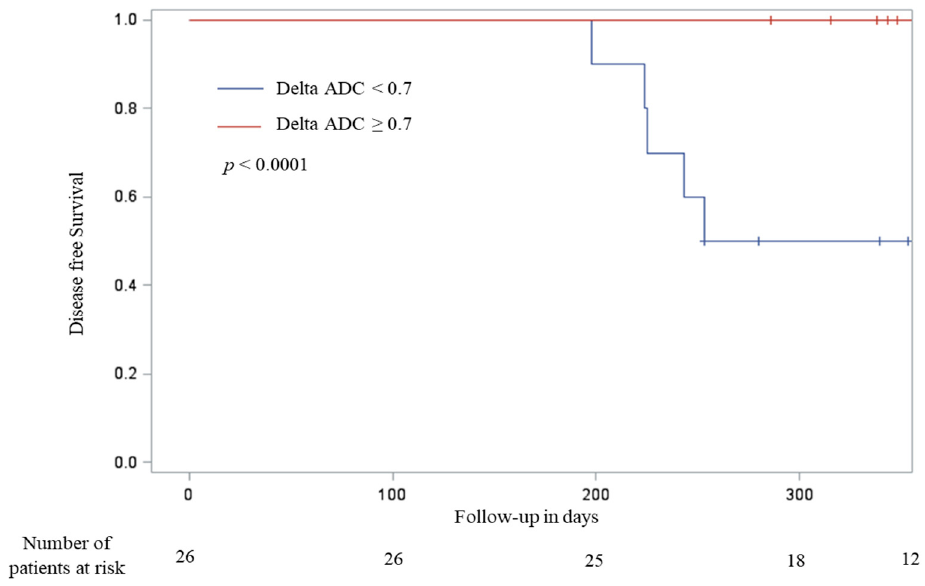
Figure 4. Recurrence-free survival according to tumor delta ADC (greater or lower than 0.7).